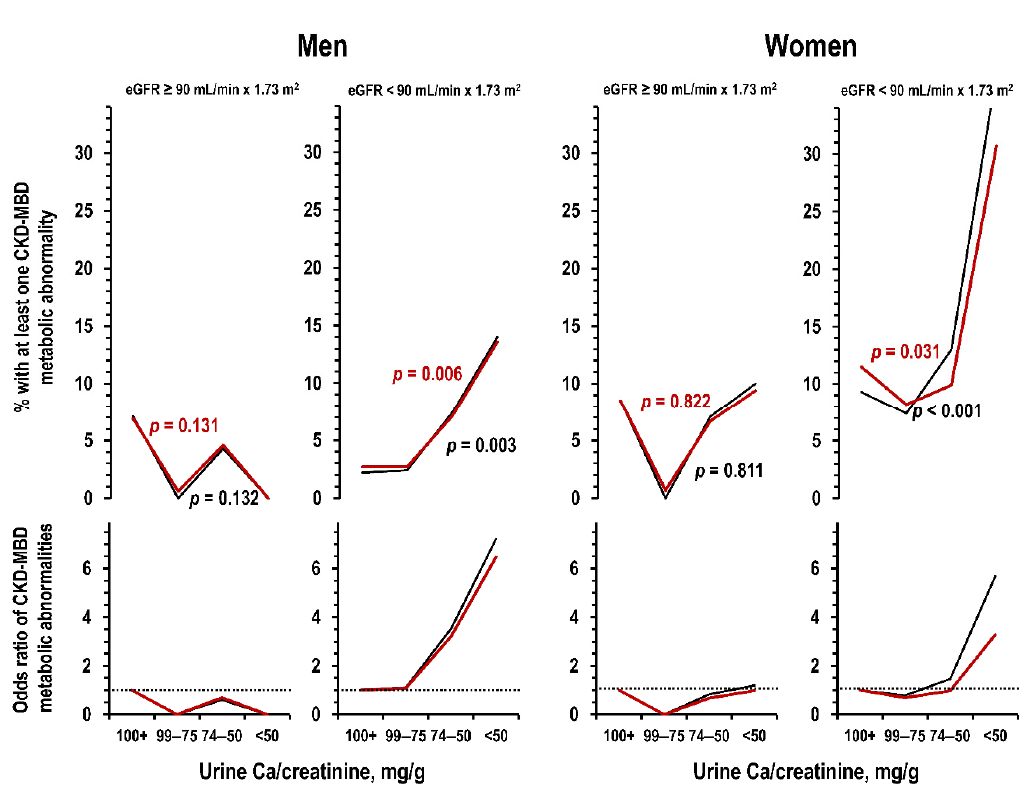
4. Discussion This observational, population-based, cross-sectional analysis reported two main findings. First, there is a continuous, graded, and independent association of lower kidney function with lower urine Ca and, as expected, with lower glomerular filtered load of Ca, in the absence of alterations in the tubular Ca handling. Second, in individuals with reduced kidney function, the relative hypocalciuria independently associates with increased prevalence of low serum 1,25(OH) 2 D. The interpretation of observational, cross-sectional data should be cautious. Study results indicated that a reduction in the glomerular filtered Ca load was the sole mechanism responsible for the relative hypocalciuria associated with reduced kidney function, at least over the eGFR range explorable in the two population samples in analysis. This interpretation was coherently supported by different observations: the consistence of results in urine samples under fed condition and after prolonged fast, the independence of findings of dietary markers, Ca supplementation, and duration of overnight fast. The lack of altered tubular Ca handling in reduced kidney function appeared coherent with the concurrence of conditions capable either to up-regulate and to down-regulate